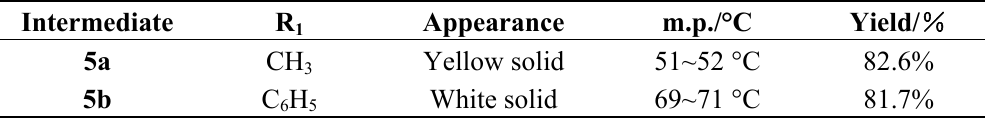
Table 4. Appearance, melting points and yields of intermediates 5a – b